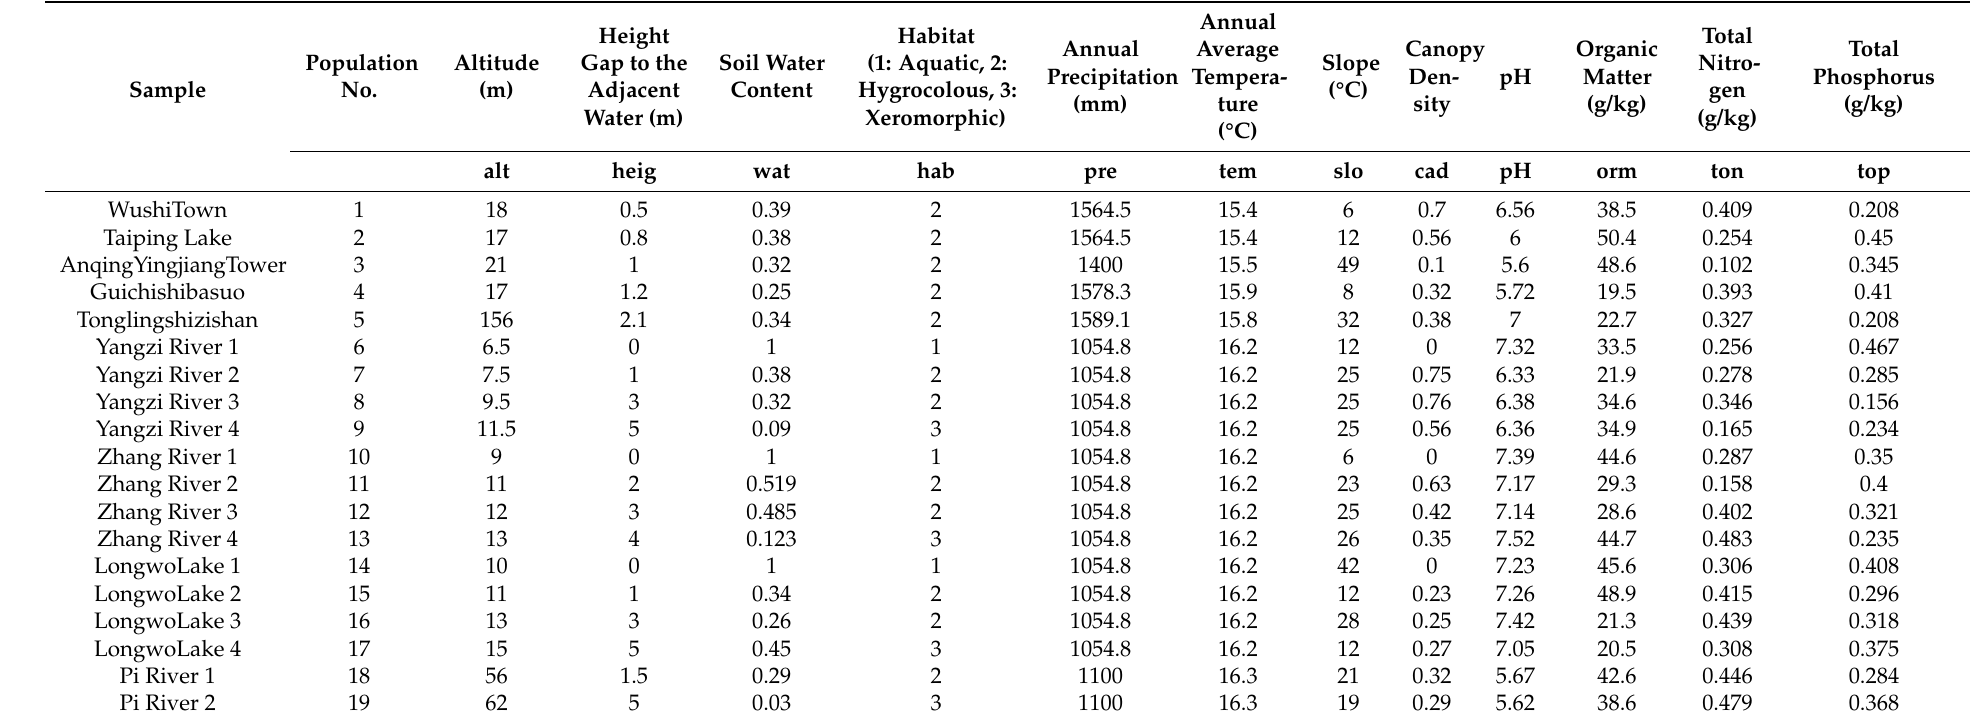
Table 3. Characteristics of the environmental factors of P. criopolitanum